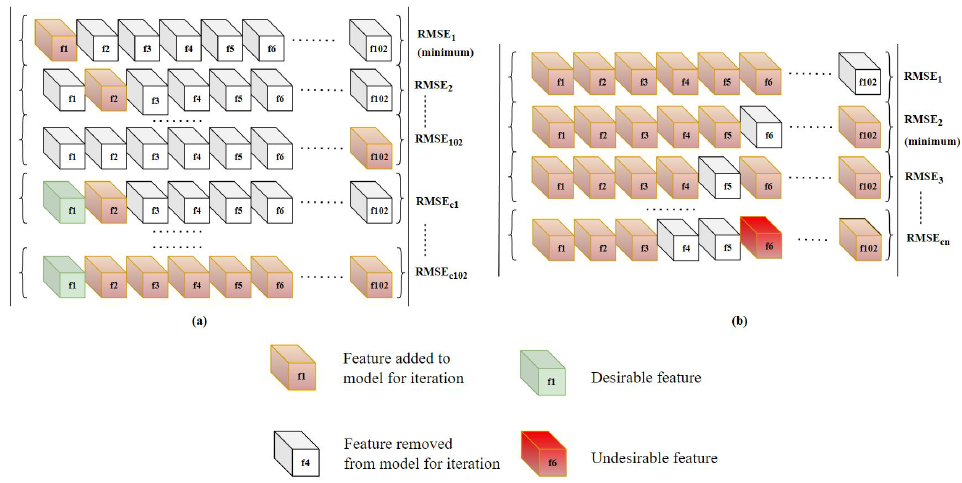
Figure 1. Diagrammatic representation of Greedy-based feature selection. Each sub-figure shows the process of: ( a ) Sequential forward feature selection. ( b ) Sequential backward feature